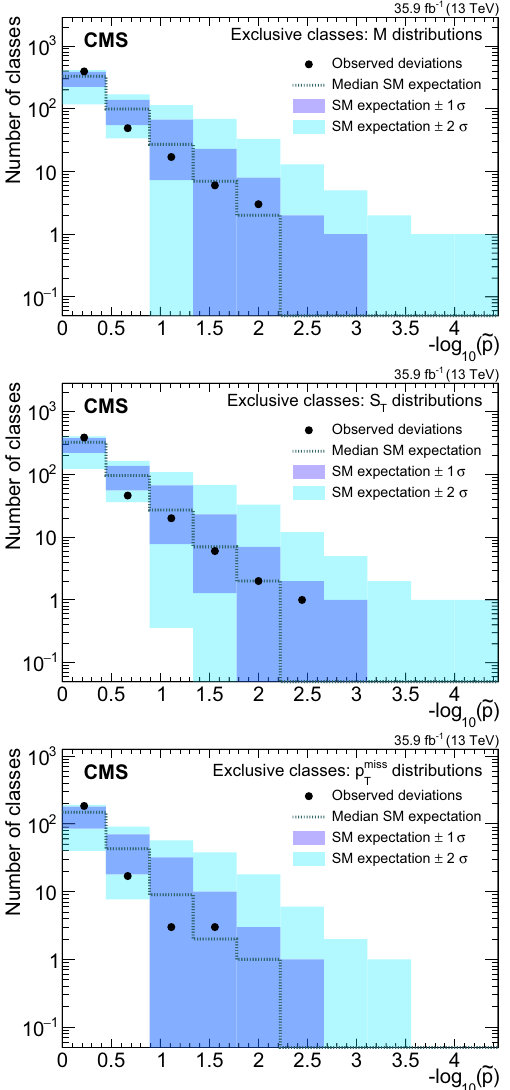
Fig. 12 Distribution of ˜ p values for the RoI scan in inclusive classes (lower) distributions for the M (upper), S T (middle), and p miss T